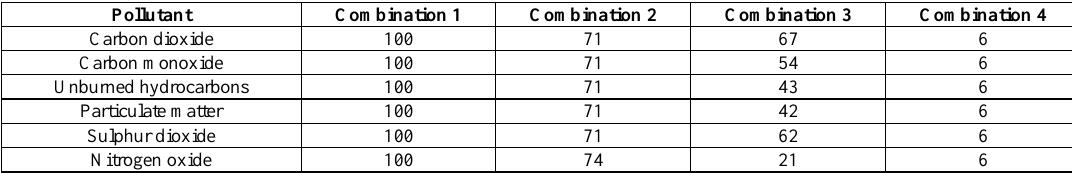
Table 2. Percentage pollutant emissions for various combinations.